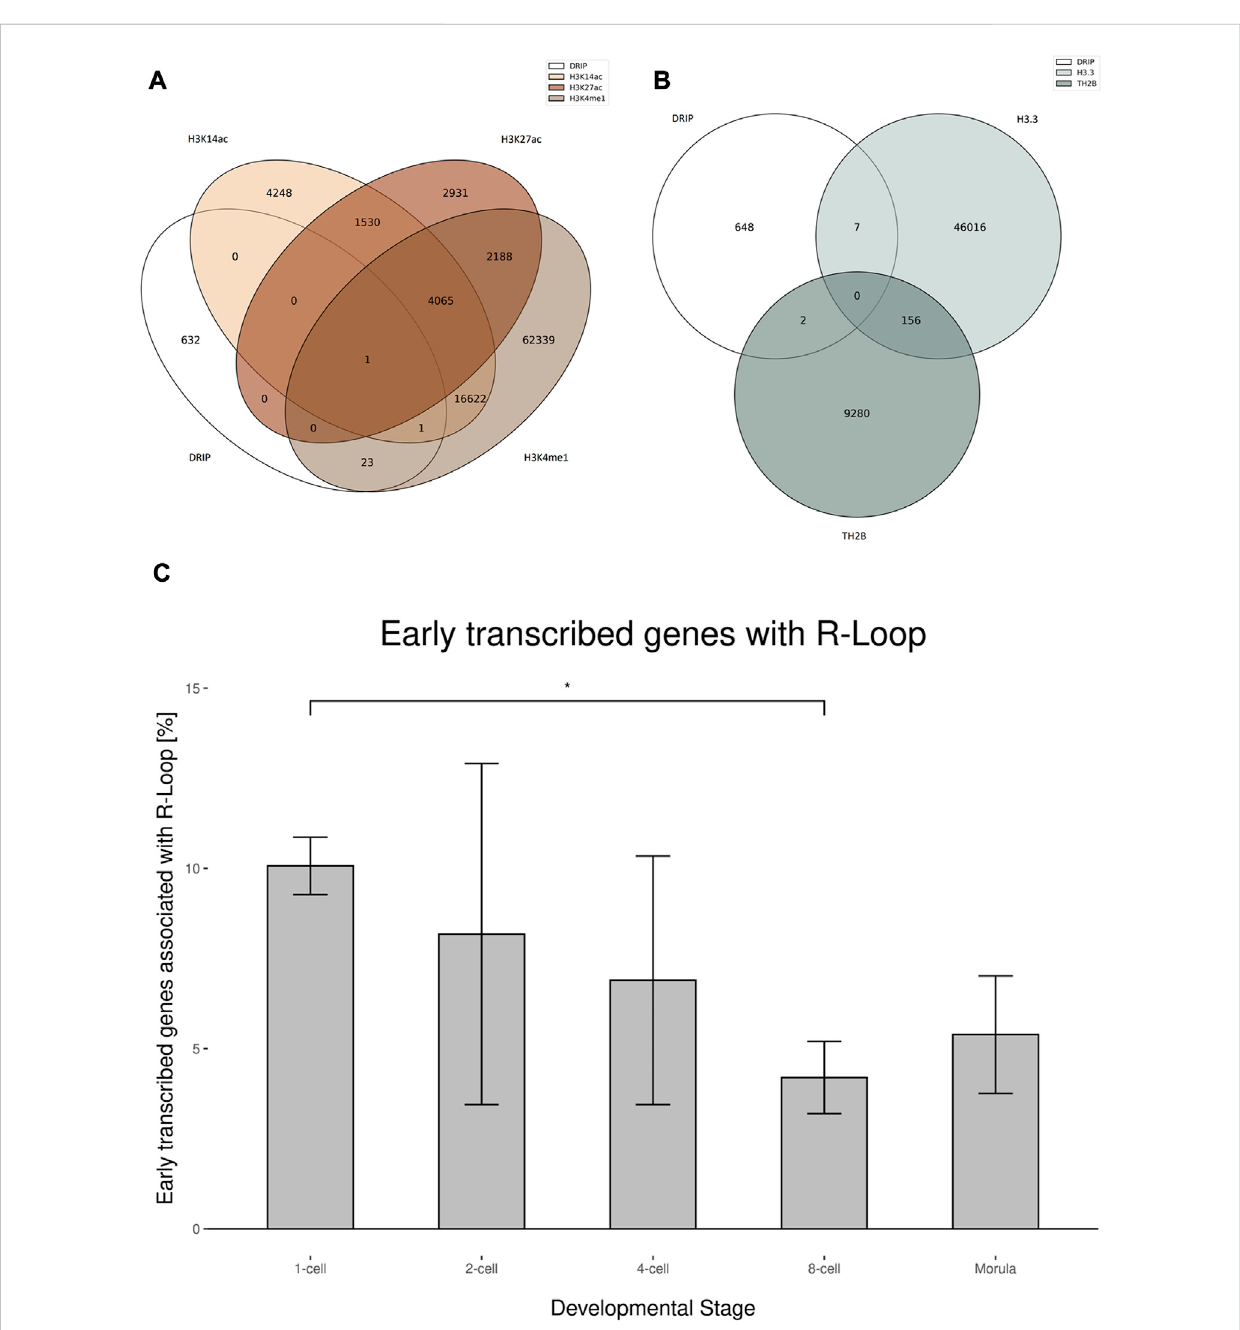
FIGURE 5 Potential epigenetic effective R-loops in sperm (A) Venn diagrams showing the overlap between R-loops and residual histones H3K14ac, H3K4me1 and H3K27ac in human sperm. The overlapping peaks of DRIP replicates were used. (B) Venn diagrams showing the overlap between R-loops and residual histones H3.3 and TH2B in human sperm. The overlapping peaks of DRIP replicates was used. (C) Fraction of early transcribed genes in the human zygote by developmental stage associated with R-loops in human sperm. Error bars shows ±SEM among the biological replicates. Two- tailed Student ’ s t-test was used to test for signi fi cance ( p <